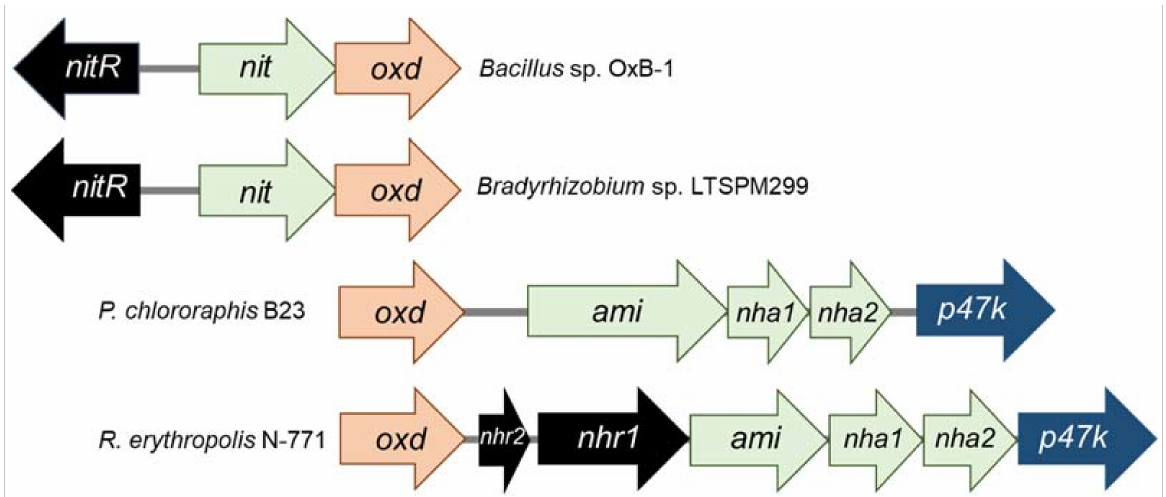
Figure 4. Genes encoding enzymes of the aldoxime-nitrile pathway form clusters (according to [15,21,23,24], modified). Examples: Bacillus sp. OxB-1, Bradyrhizobium sp. LTSPM299, Pseu- domonas chlororaphis B23, and Rhodococcus erythropolis N-771. Encoded enzymes: nit , NLase; nha1 , NHase α -subunit; nha2 , NHase β -subunit. Blue arrows indicate genes coding for the putative NHase activator P47K. Black arrows indicate genes coding for putative transcriptional regulators (type specified). The flanking regions in P. chlororaphis and R. erythropolis contain some unidentified genes (not